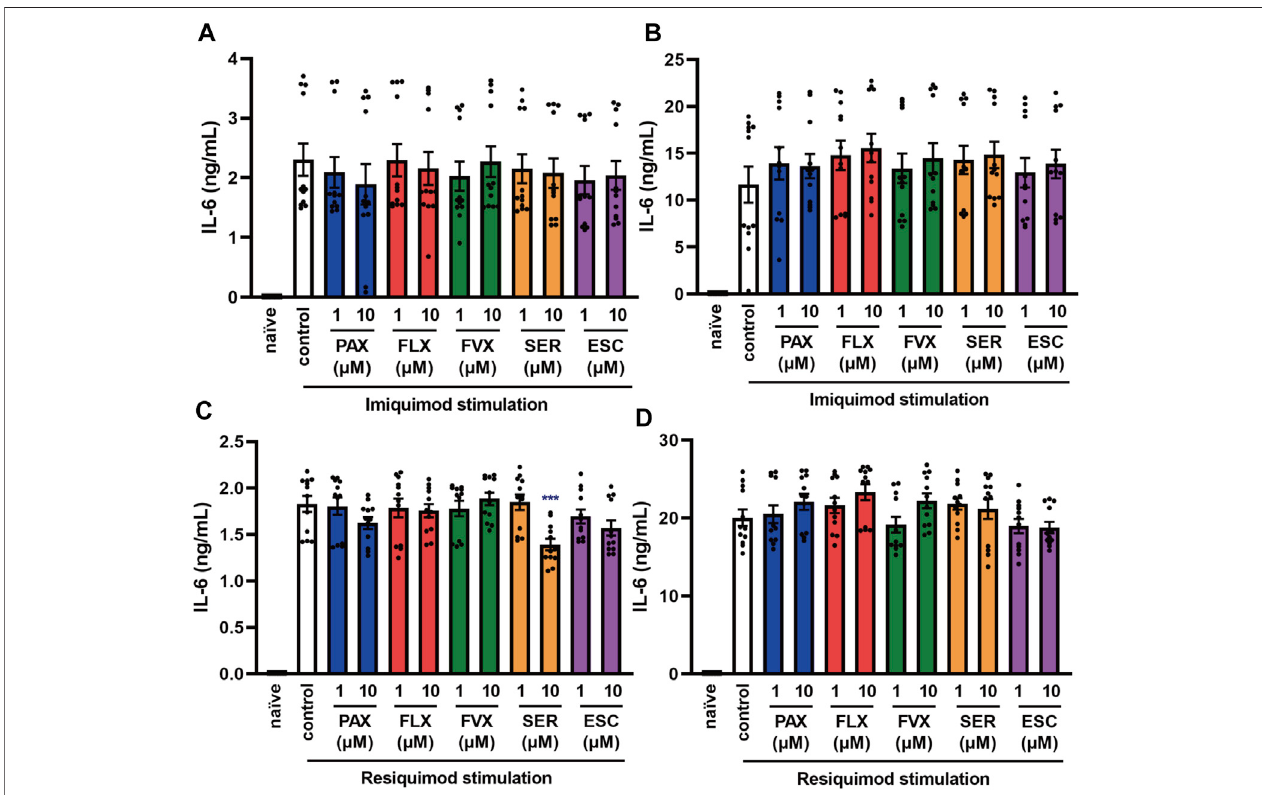
FIGURE 4 | Effects of SSRIs on IL-6 production induced by TLR7 agonists in J774.1 murine macrophage cells. J774.1 cells were pre-incubated with each SSRI (1 – 10 µM)for30 minandthenincubatedwithimiquimod(1 μ g/ml)for6 h (A) or24 h (B) ,orresiquimod(10 ng/ml)for6 h (C) or24 h (D) .IL-6wasmeasuredbymeansof ELISA. Error bars indicate ±SE (n = 12, three independent experiments). Statistical analysis was performed by one-way ANOVA followed by Dunnett ’ s test. Signi fi cant differences betweencontroland test groupsare indicatedby *** p < 0.001. PAX, paroxetine; FLX, fl uoxetine; FVX, fl uvoxamine;SER, sertraline; ESC,escitalopram.